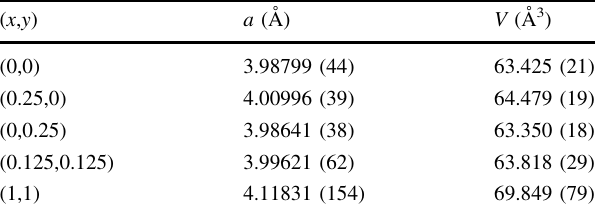
Table 2 Unit cell parameters of cubic Sr 1 - x Ba x W 1 - y Ta y (O,N) 3 ( x , y = 0,0; 0.25,0; 0,0.25; and 0.125,0.125) crystal structures syn- thesized by thermal ammonolysis of oxide precursors at 900–950 (cid:3) C for 10–40 h under an NH 3 flow